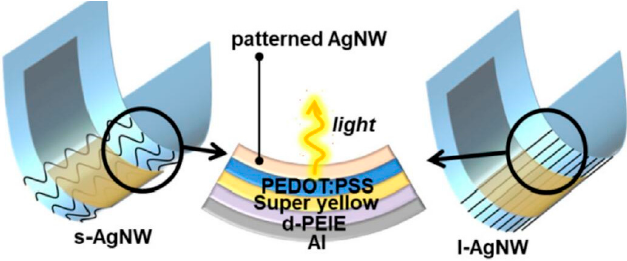
Figure 10. s-AgNW- and l-AgNW-type flexible OLEDs. Reprinted with permission from [101]; Copyright 2019 Elsevier.